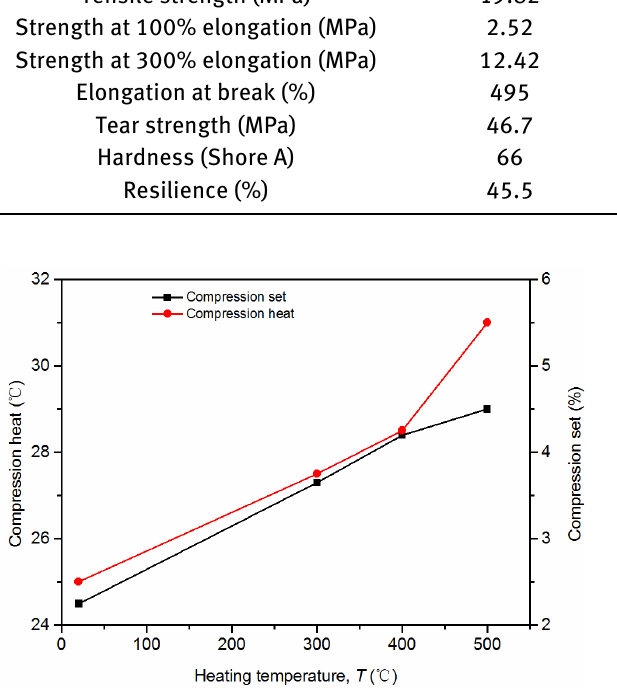
Figure 13: Compression heat and compression set versus tempera- ture of vulcanized rubber filled with N660